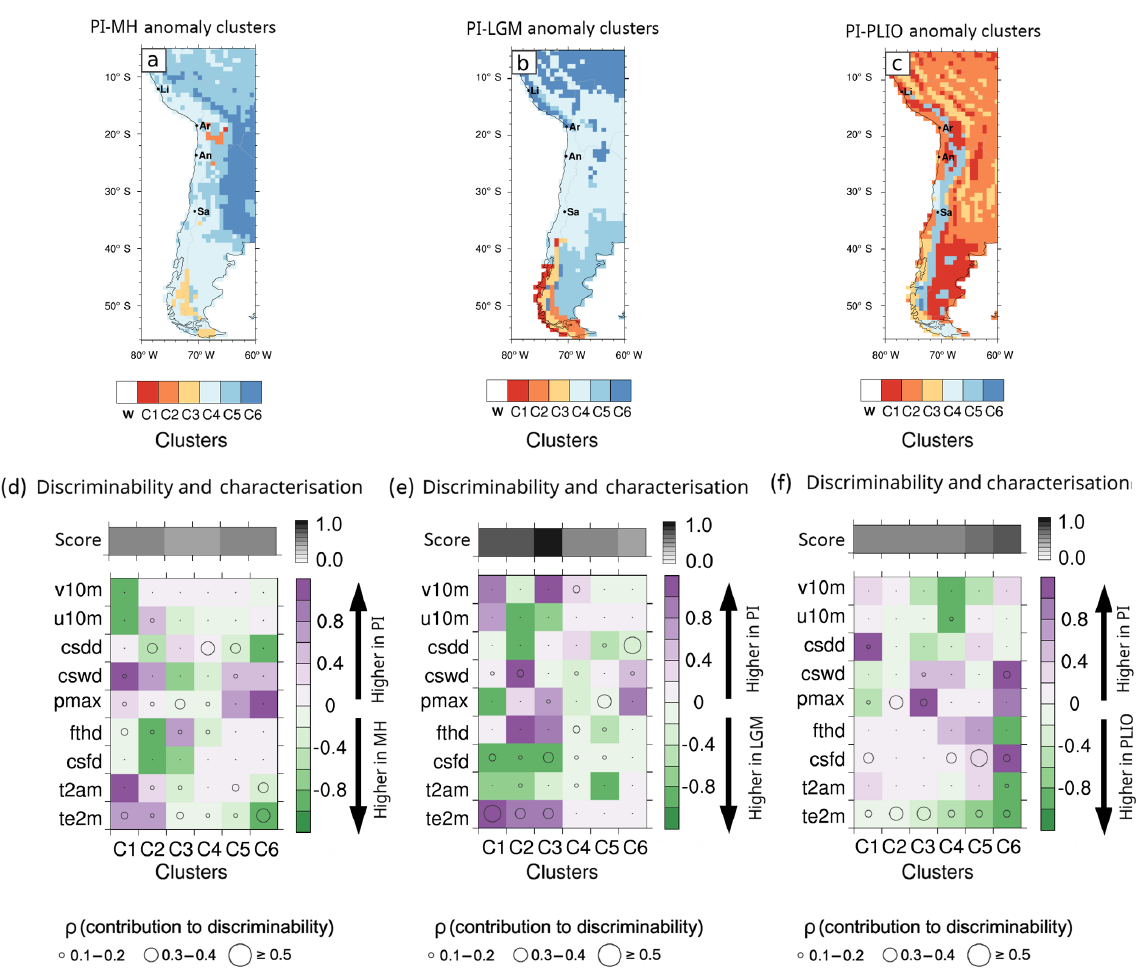
Figure 3. The multivariate anomaly maps for time slice comparisons PI–MH (a) , PI–LGM (b) and PI–PLIO (c) show the geographical coverage of clusters C 1 – C i in western South America, which describe the spatial extent of regions characterised by similar modes of change. The corresponding modes of change (d, e, f) for each cluster are expressed as relative changes in each of the nine investigated variables (Table 1): 2m air temperature (te2m), 2m air temperature amplitude (t2am), consecutive freezing days (csfd), freeze–thaw days (fthd), maximum precipitation (pmax), consecutive wet days (cswd), consecutive dry days (csdd), zonal near-surface wind speeds ( u